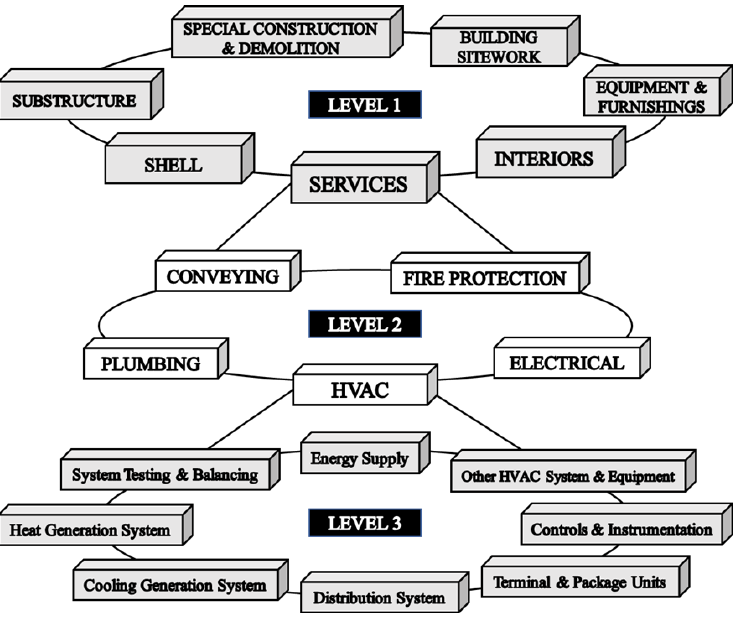
Figure 4. Uniformat II classification [23].